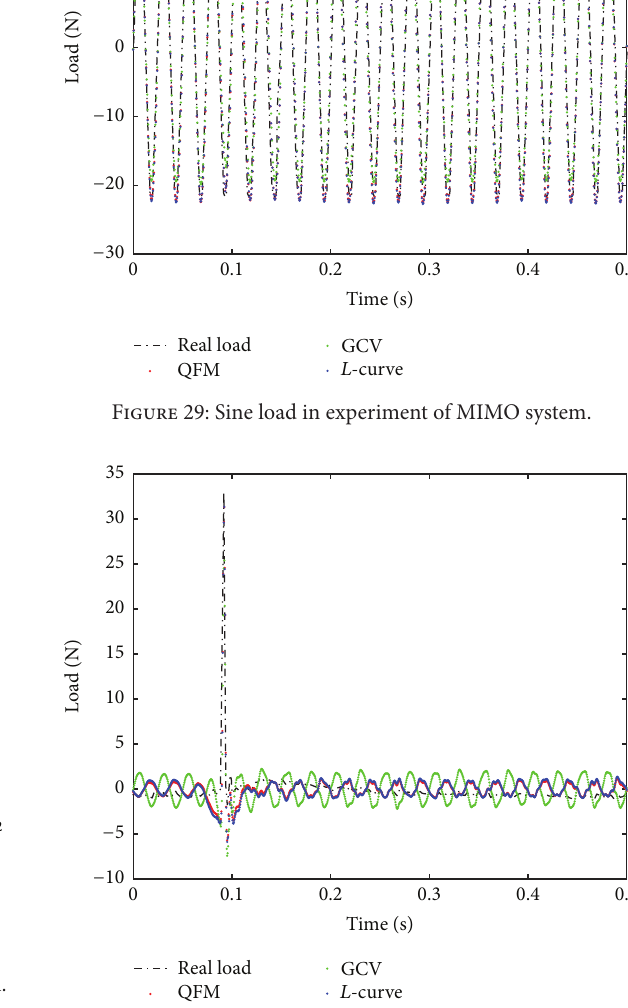
Figure 30: Impact load in experiment of MIMO